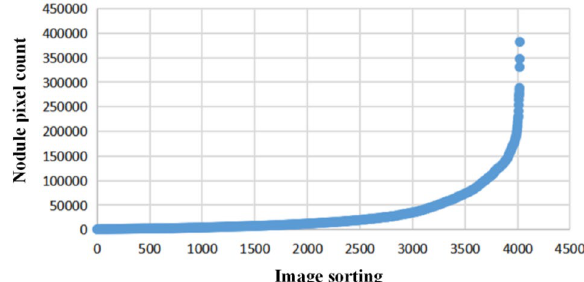
Figure 4. Statistics of the numbers of pixels of nodules.